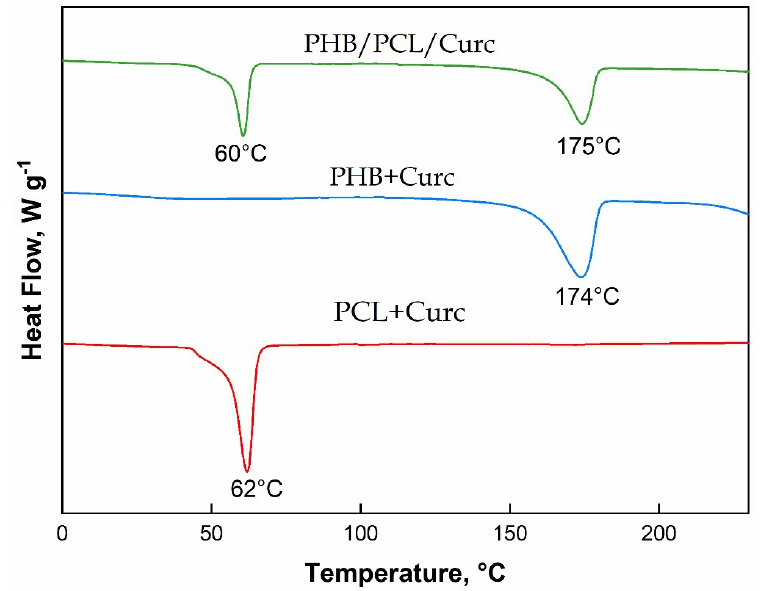
Figure 5. Di ff erential scanning calorimetry (DSC) of electrospun PCL, PHB and PCL / PHB loaded Figure 5. Differential scanning calorimetry (DSC) of electrospun PCL, PHB and PCL/PHB loaded with with Curcumin.